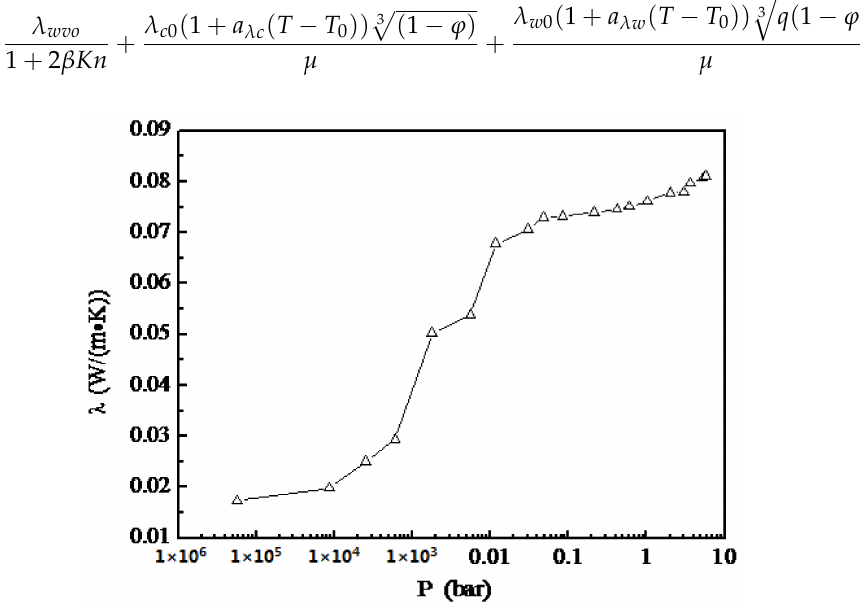
Figure 5. Effective thermal conductivity at different